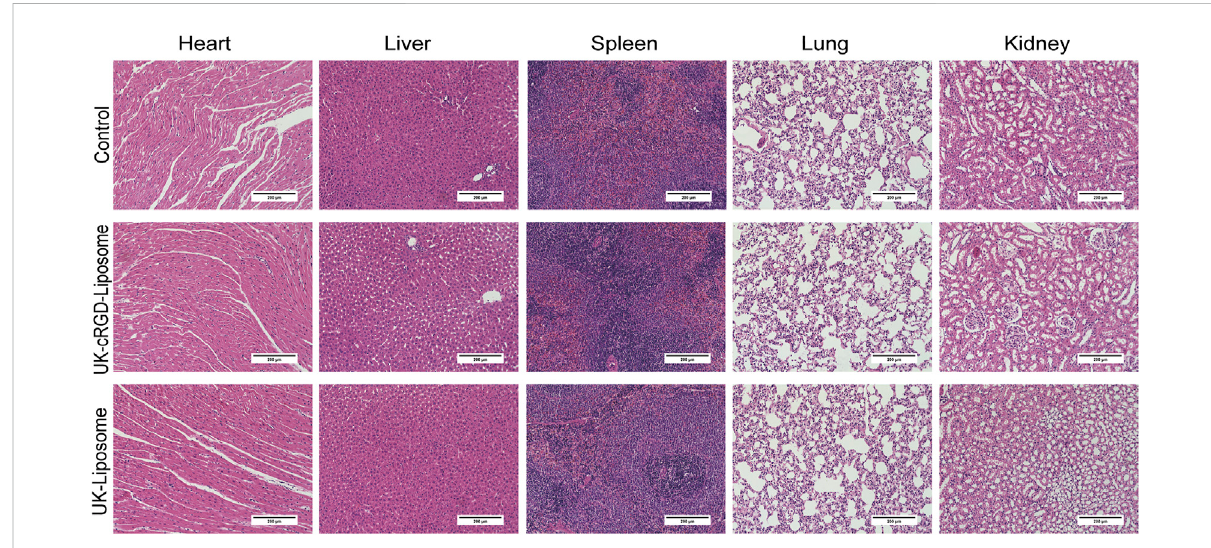
FIGURE 10 H & E staining of the major organs collected from healthy SD rats 1 week after tail vein injection of UK-cRGD-Liposome, UK-Liposome or normal saline (Control). Abbreviations: UK-cRGD-Liposome, urokinase-loaded cycle RGD-decorated liposome; UK-Liposome, urokinase-loaded